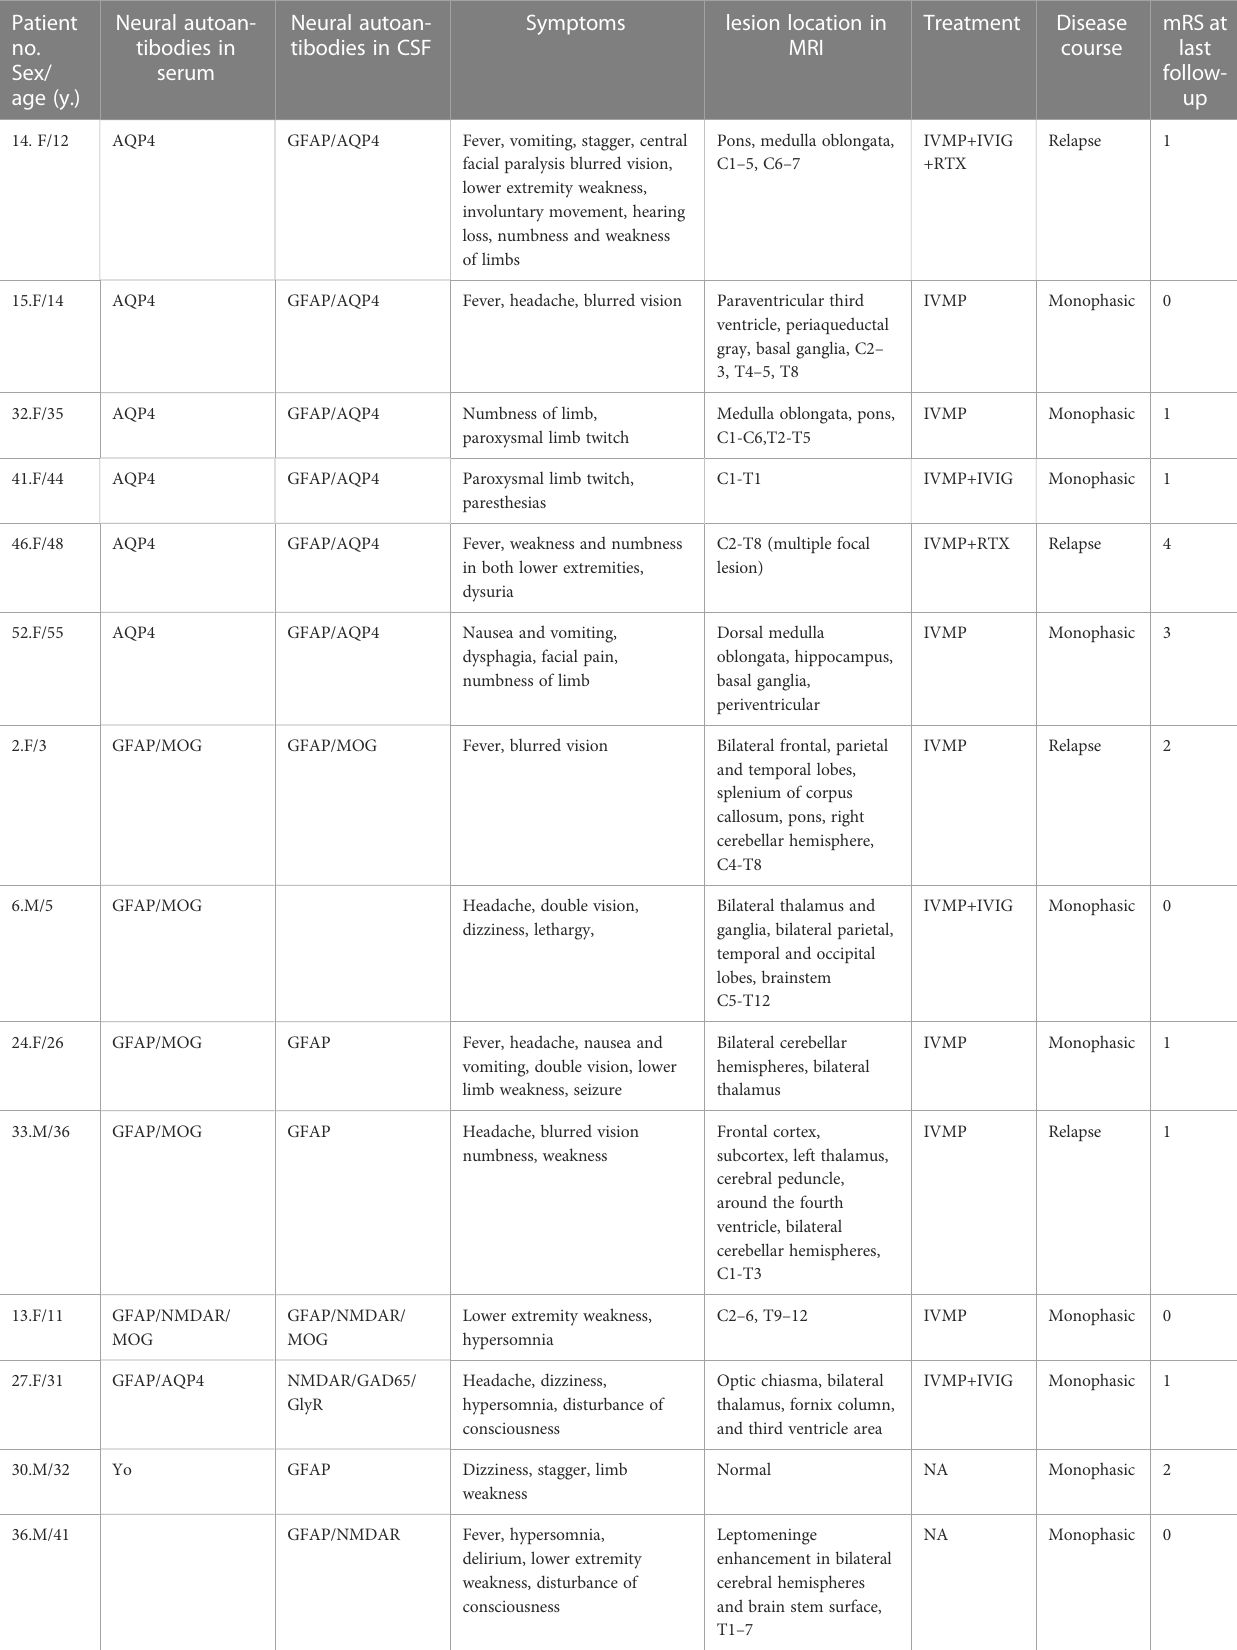
F, female; M, male; C, cervical spinal cord; T, thoracic spinal cord; IVMP, intravenous methylprednisolone; IVIG, intravenous immune globulin; RTX, rituximab; mRS, modi fi ed Rankin Scale; NA, not available; MRI, magnetic resonance